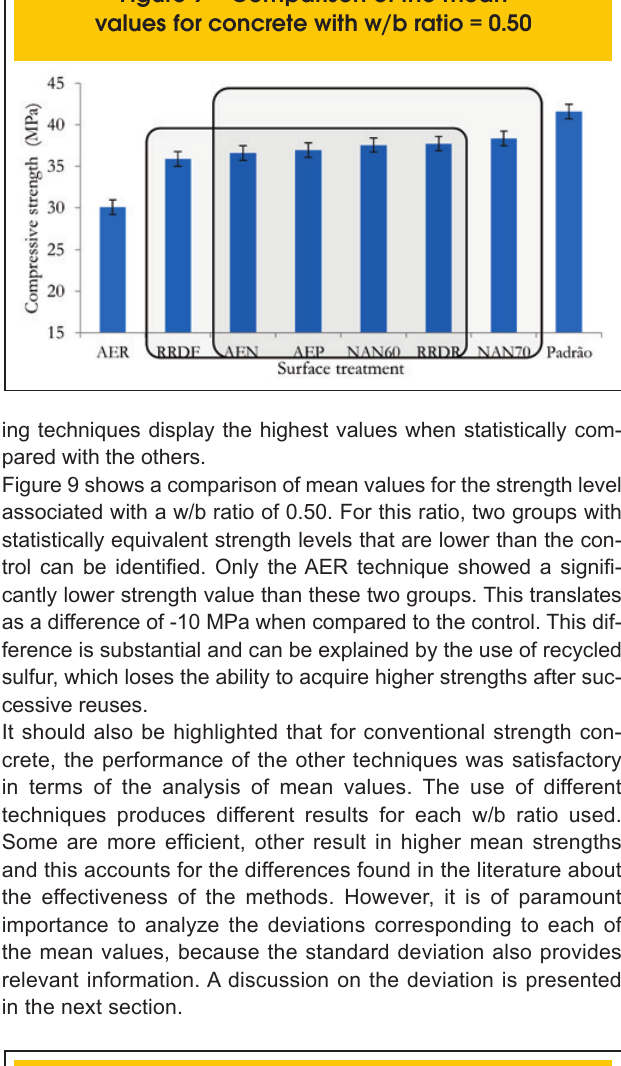
Figure 7 – Comparison of the mean values for concrete with w/b ratio = 0.70